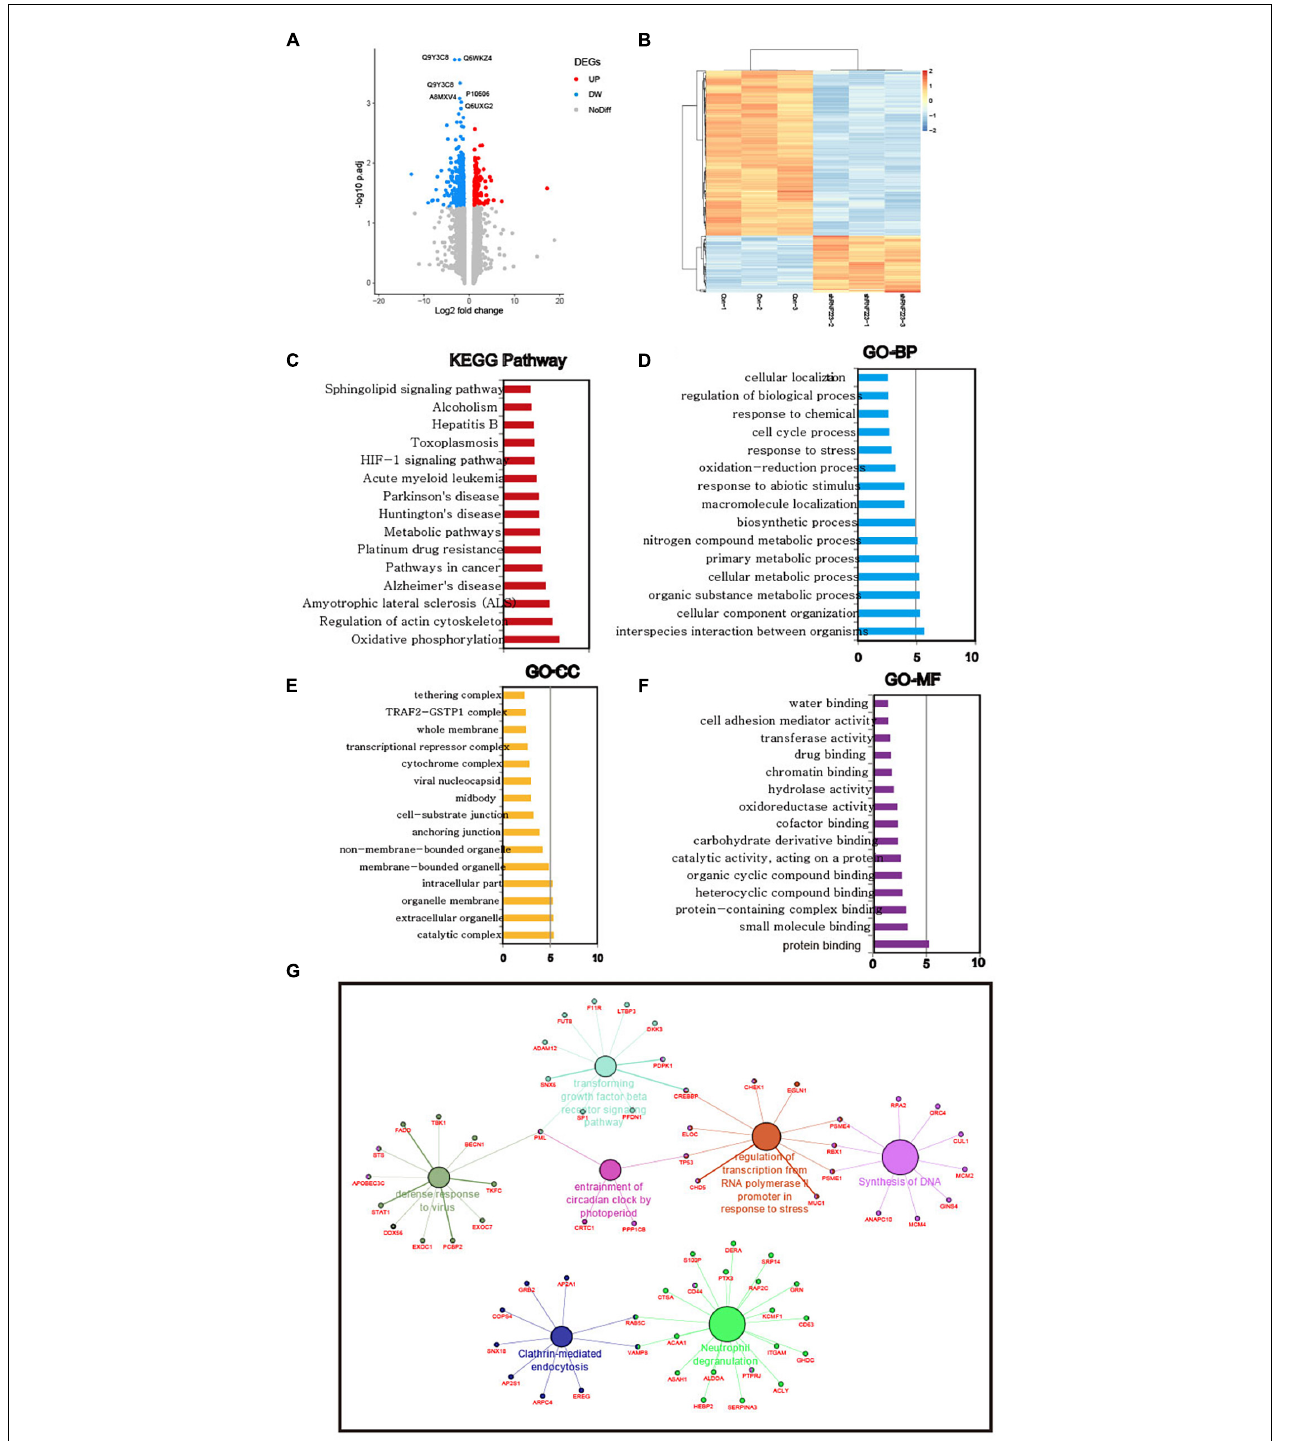
FIGURE 6 | Quantitative proteomics analysis reveals pathways and BPs in the RNF223-silenced ASPC-1 cell line. (A) Analysis of DEGs in RNF223 knockdown ASPC-1 cells is shown using a volcano plot. Upregulated genes are shown as red dots, downregulated genes are shown as blue dots, and genes with no significant differential expression are shown as gray dots. (B) Supervised hierarchical clustering of the DEGs in RNF223 knockdown ASPC-1 cells. (C) The top 15 significantly enriched KEGG pathways of the DEGs in RNF223 knockdown ASPC-1 cells. (D) The top 15 significantly enriched Gene Ontology BPs of the DEGs in RNF223 knockdown ASPC-1 cells. (E) The top 15 significantly enriched Gene Ontology CCs of the DEGs in RNF223 knockdown ASPC-1 cells. (F) The top 15 significantly enriched Gene Ontology MFs of the DEGs in RNF223 knockdown ASPC-1 cells. (G) Functional network of the DEGs in pathways and BPs.